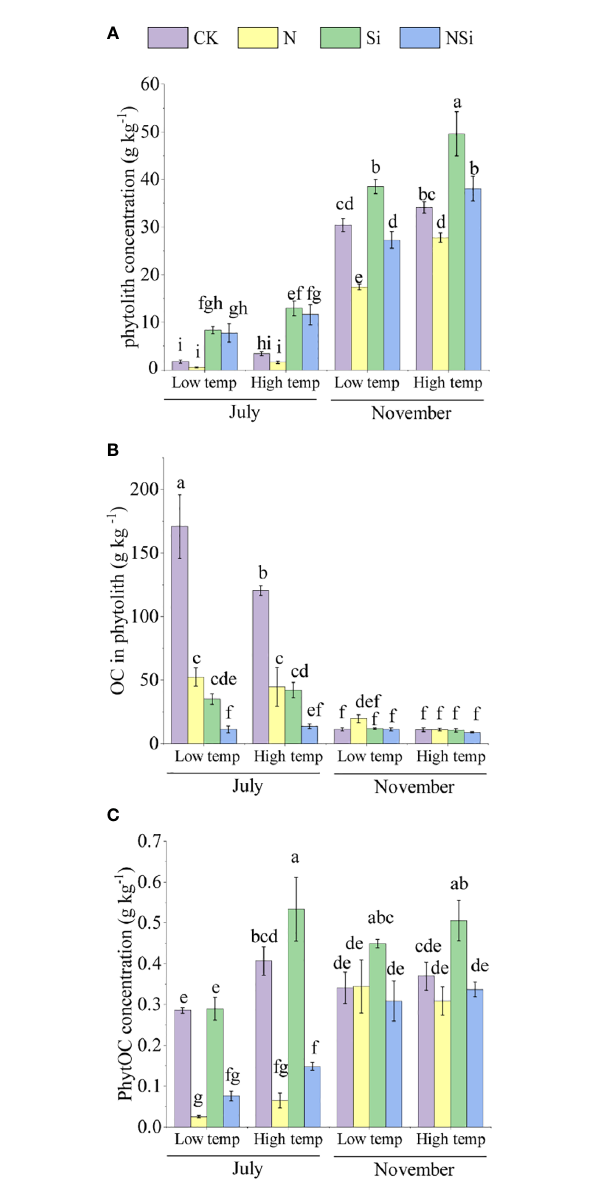
FIGURE 2 The concentration of (A) Moso bamboo leaves ’ phytolith, (B) OC in phytolith, and (C) PhytOC with different fertilization at low and high temperature in July and November. CK, N, Si, and NSi represent the level of fertilization at 0N 0Si kg/hm 2 , N157.5 kg/hm 2 , Si 315 kg/hm 2 , N157.5 kg/hm 2 and Si 315 kg/hm 2 , respectively. Error bars represent the standard error of the means. Different letters indicate signi fi cant differences among the treatments of different fertilization at 0.05 level,